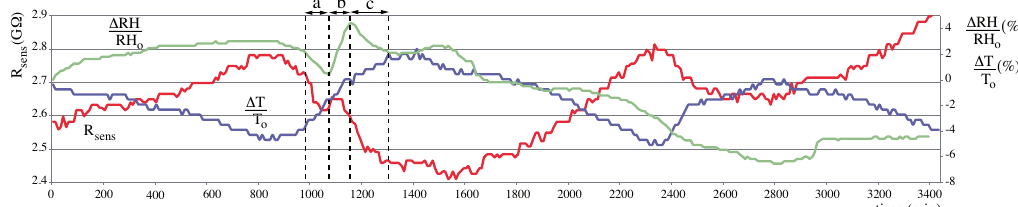
Figure 8. Steady-state analysis #1. Sample B (Maritime pine) measurements during 58 h. Red: R sens , blue: temperature variation percentage, green: ambient humidity variation